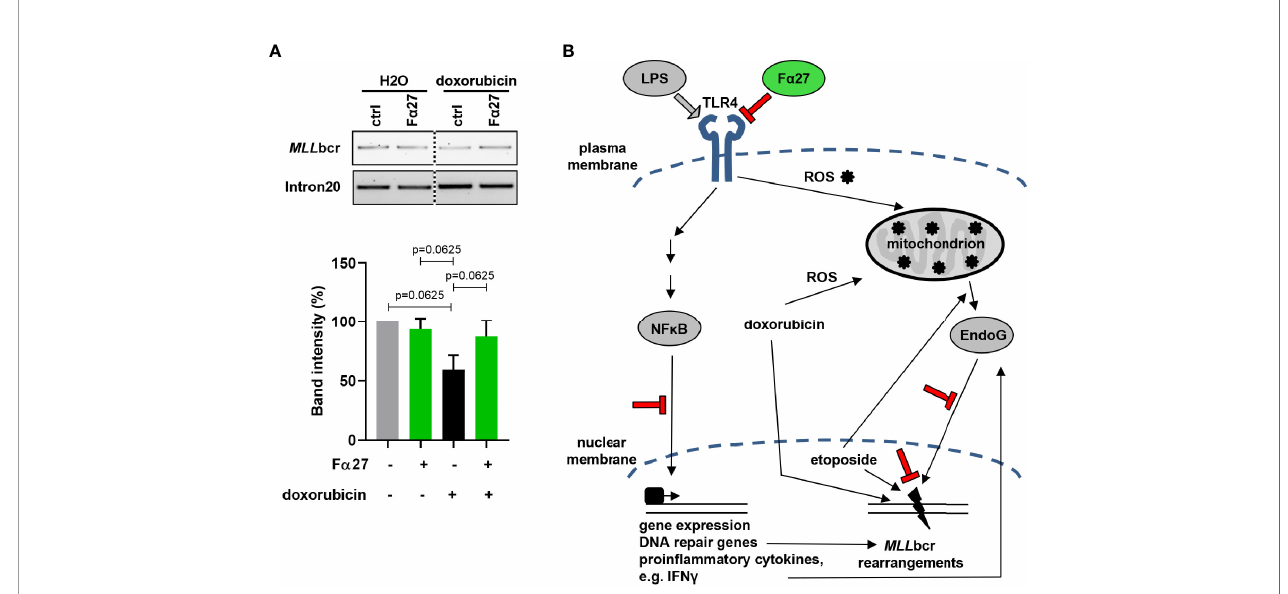
FIGURE 8 | F a 27 prevents MLL bcr breakage inHSPCs. (A) MLL bcr breakage analysis after doxorubicin andF a 27 treatment of HSPCs. HSPCs were treated 4 h with 10 µg/ml F a 27 followedby 4 h of treatment with F a 27 plus0.072 µM doxorubicin. After genomic DNA isolation breakage was assessed byPCR targeting the endogenous MLL bcr locus. Doxorubicin treatment increased breakageas indicatedby a 40% decrease of the bandintensity, which was reduced inF a 27 pre-treated cells byonly 13%. Data from fi ve independent experiments are shownas mean +SEM (Friedman-Test indicating p=0.0087, followed byWilcoxon test). The framed image shows MLL bcr PCR ampli fi cationsfromthe same gel exposed with the same intensity and croppedat the dotted line. MLL intron20 was ampli fi edas control. (B) Model of MLL bcr protection by F a 27. LPS activation ofTLR4 leadsto NF k B-mediated gene expression of DNA repair genes andproin fl ammatory cytokines liketype I interferons (51).The interferon IFN g can increase EndoG release from the mitochondria(52).Etoposide, a topoisomerase II inhibitor, induces DNA damage andEndoG release from the mitochondria(53). Doxorubicin, a drug with a broad spectrum of cell damage, intercalates into the DNA, which promotes translocation of EndoG from mitochondria to the nucleus. Nuclear EndoG cleaves the MLL bcr predicted to formpronounced secondarystructures. Stimulation of TLR4, such as byLPS, was as wellreported to increase ROS production in mitochondria (54),againinducing DNA damage. Weshow that F a 27 blocksTLR4 activation and downstream NF k B signaling. Furthermore, EndoG accumulation in the nucleusisreduced and the MLL gene protected from breakage. Findings madein this work are indicated inred